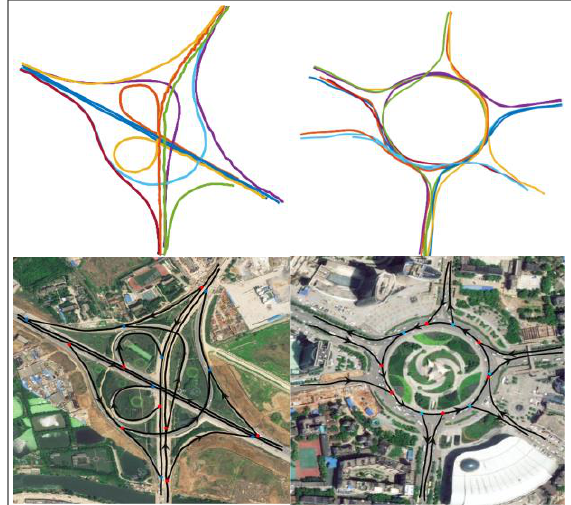
Figure 10. Geometry of overpass and roundabout using K-segment